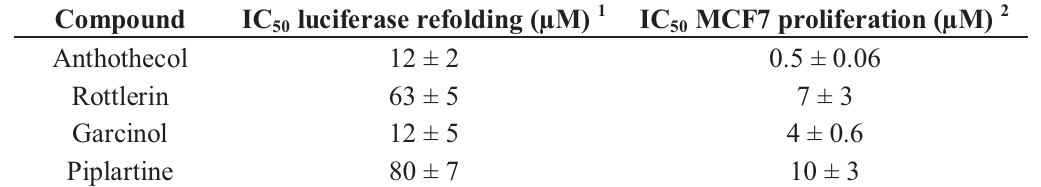
Table 11. IC50 values for inhibition of luciferase refolding and proliferation of MCF7